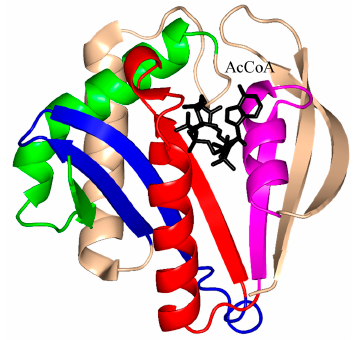
Figure 11. Cartoon representation of the structure of the tabtoxin resistance protein from Pseudomonas syringae in complex with AcCoA (PDB ID: 1GHE [114]). The conserved and non-conserved motifs of the GNAT domain are colored as in Figure 3.